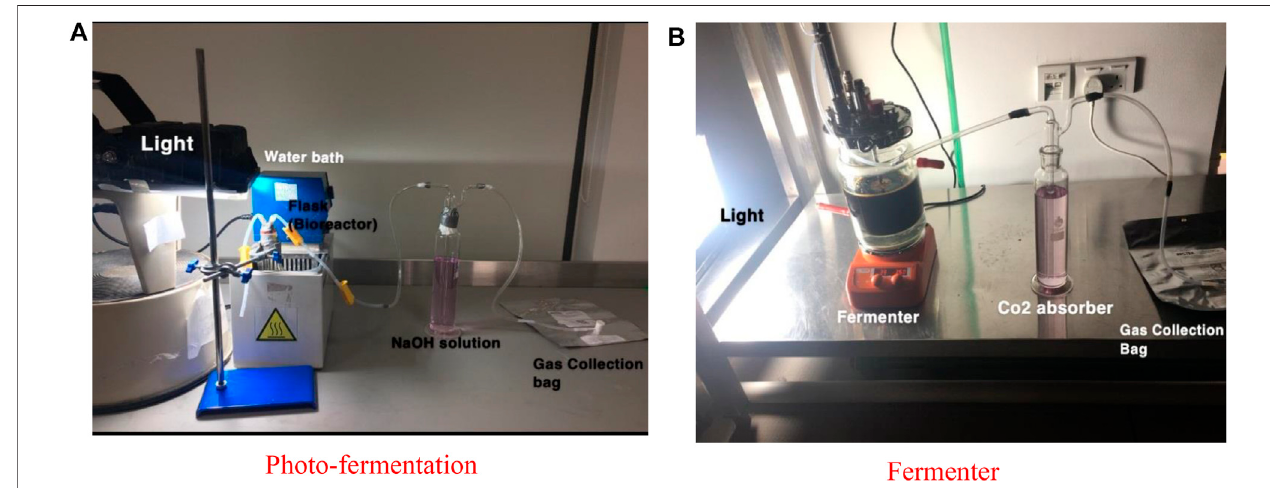
FIGURE 11 | Experimental model of the study. (A) Photo-fermentation, (B)